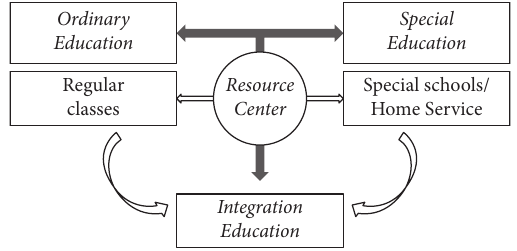
Figure 3: Relationship of special education resources in China.